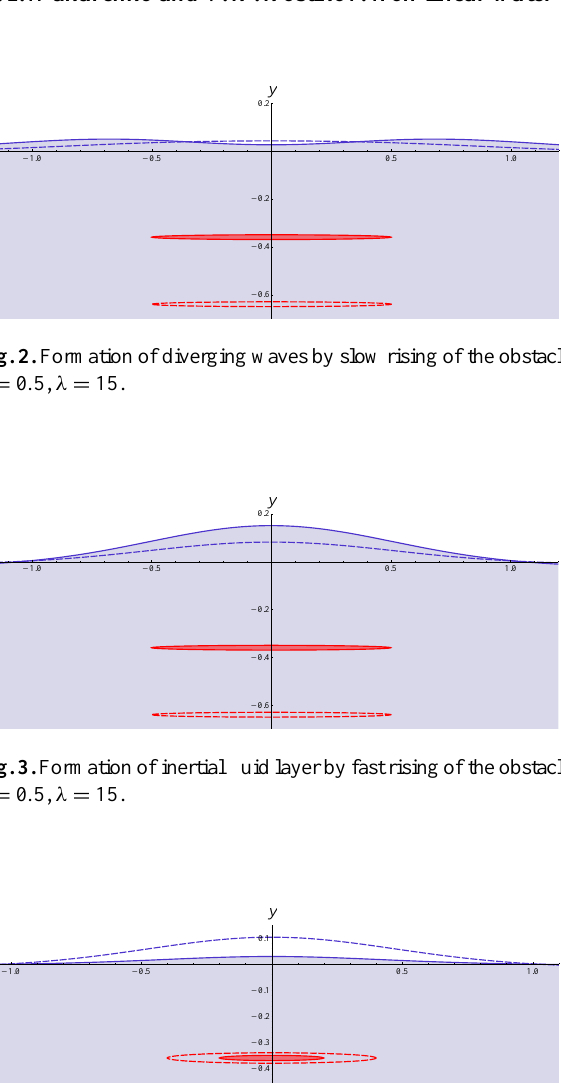
Fig. 4. Formation of added fluid mass by the obstacles with different semi-axes: a = 0 . 2 (solid lines) and a = 0 . 4 (dashed lines); λ = 5 , t = 0 . 8 .